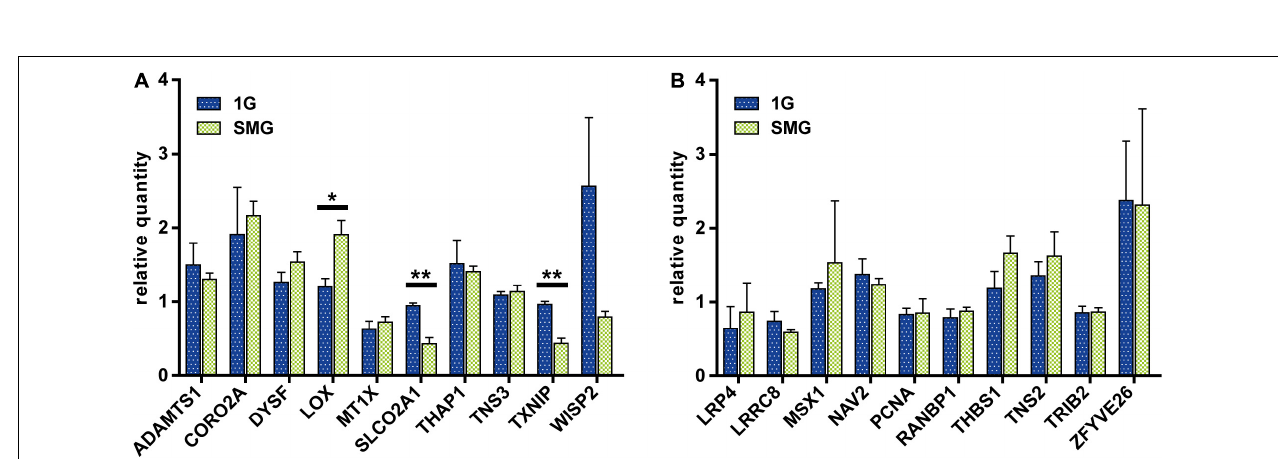
FIGURE 6 | The comparison of gene expression between the control and simulated microgravity conditions in human umbilical vein endothelial cells. (A) The gene sets were obtained from the meta-analyses of datasets from endothelial cells. (B) The gene sets were obtained from the meta-analyses of datasets from muscle samples. The relative quantity of each gene was measured using qRT-PCR and normalized to the level of 18S rRNA. For each condition n = 3. The data were expressed as the mean ± S.E.M. * p < 0.05 and ** p < 0.01.